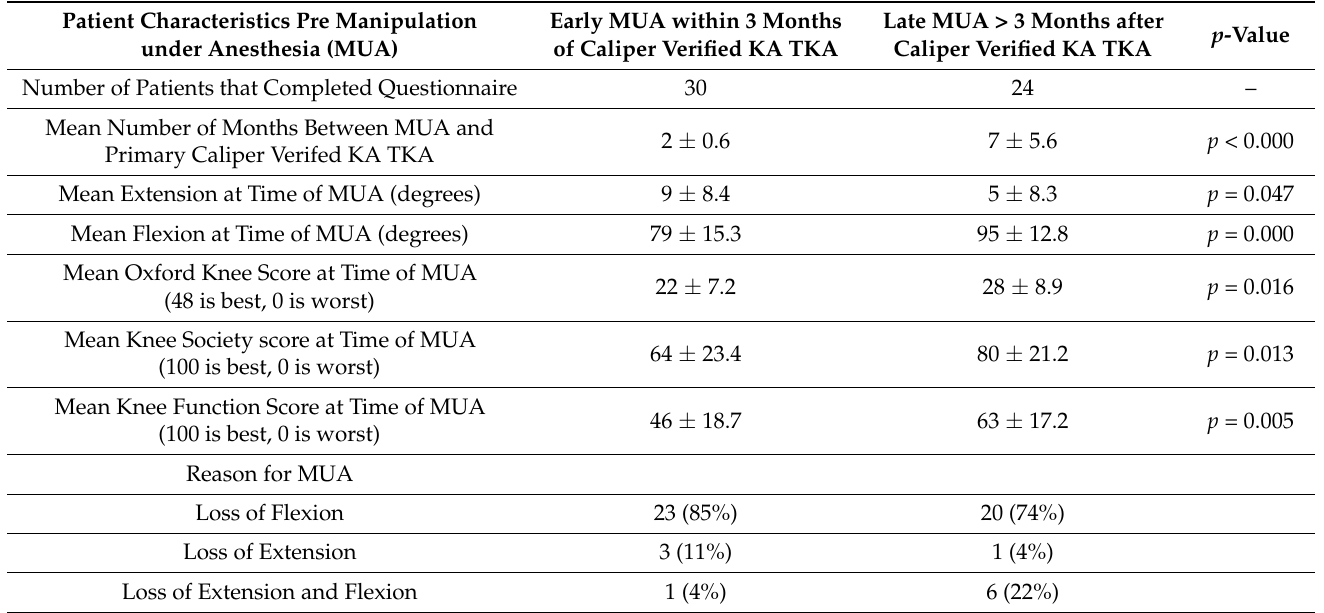
Table 2. Patient Characteristics Pre Manipulation for Patients Treated with an Early and Late